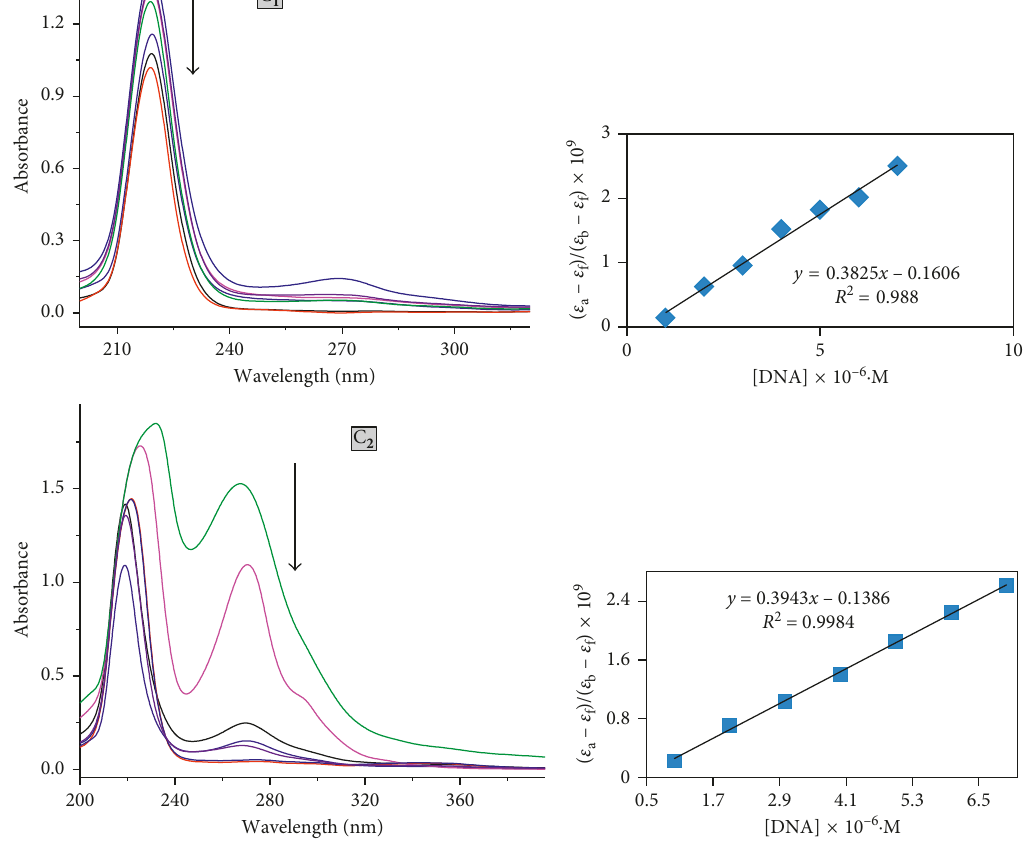
Figure 5: The electronic absorption spectra of complex C (pH 7.2). The arrows show the absorbance changes upon increasing concentration of DNA (0–25 μ M) at RT. The plot shows (cid:30) 5 versus ε f ) 10 [DNA]/( ε a × − −